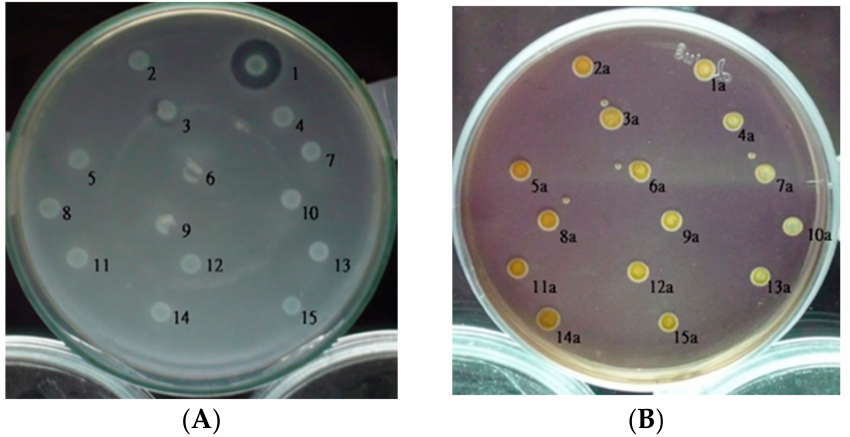
Figure 1. Bacteriocin of Pectobacterium carotovorum subsp. carotovorum . ( A ) The bacteriocin test was performed by soft agar overlay. (1) Wild-type rif-TO6 Pcc strain, (2–15) transposon Tn5